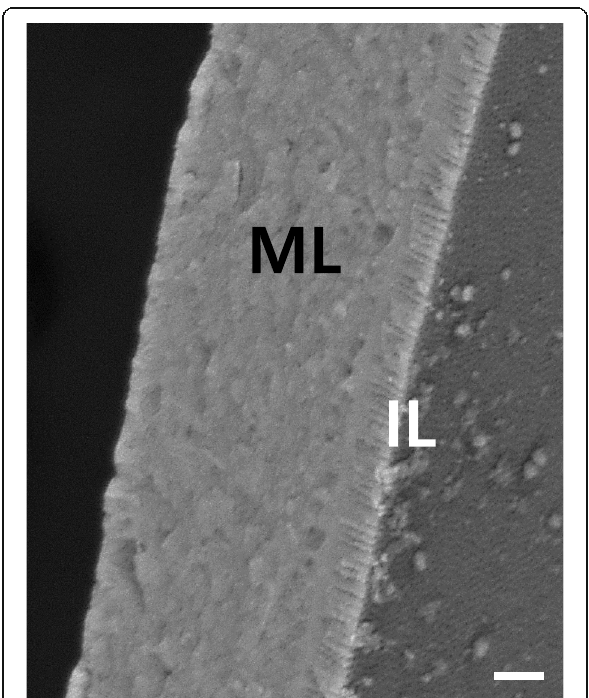
Fig. 4 Scanning electron micrograph of the fertilized egg envelopes section from A. cirrhosus . The fertilized egg envelope looks like two layers, a middle layer (ML) and an inner layer with microvilli-like pattern (IL) (Scale bar = 5 μ m)